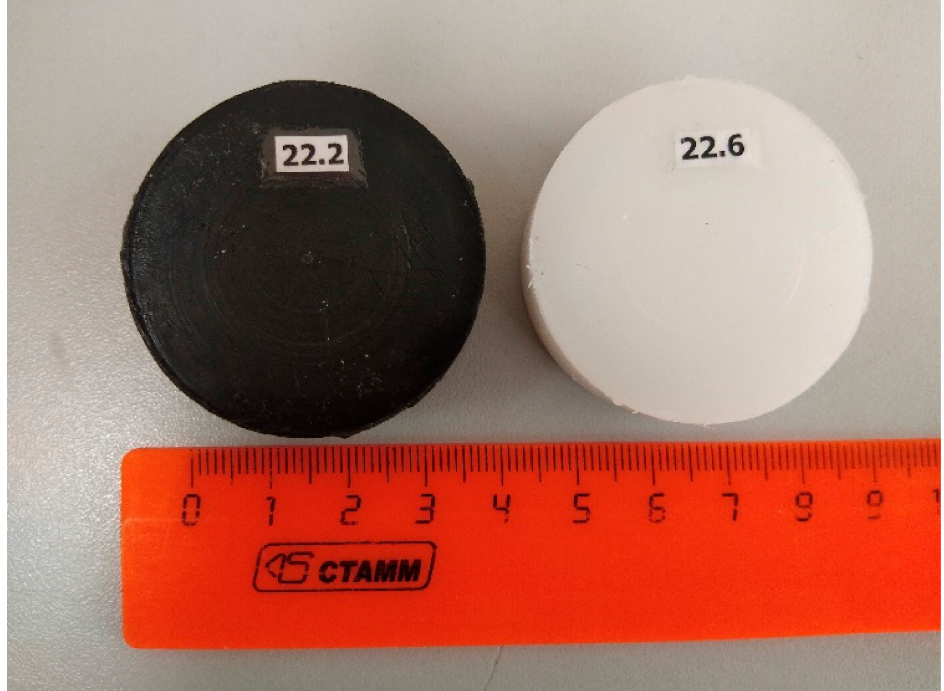
Figure 6. Compacts with a diameter of 40 mm and a height of 15 mm made of pure UHMWPE ( right ) and UHMWPE + 0.5 wt.% NDC ( left